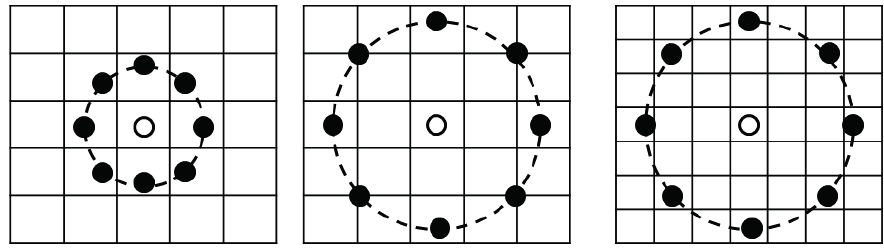
Figure 11. Multi-resolution LBP operators: LBP 8,1 , LBP 8,2 , and LBP 8,3